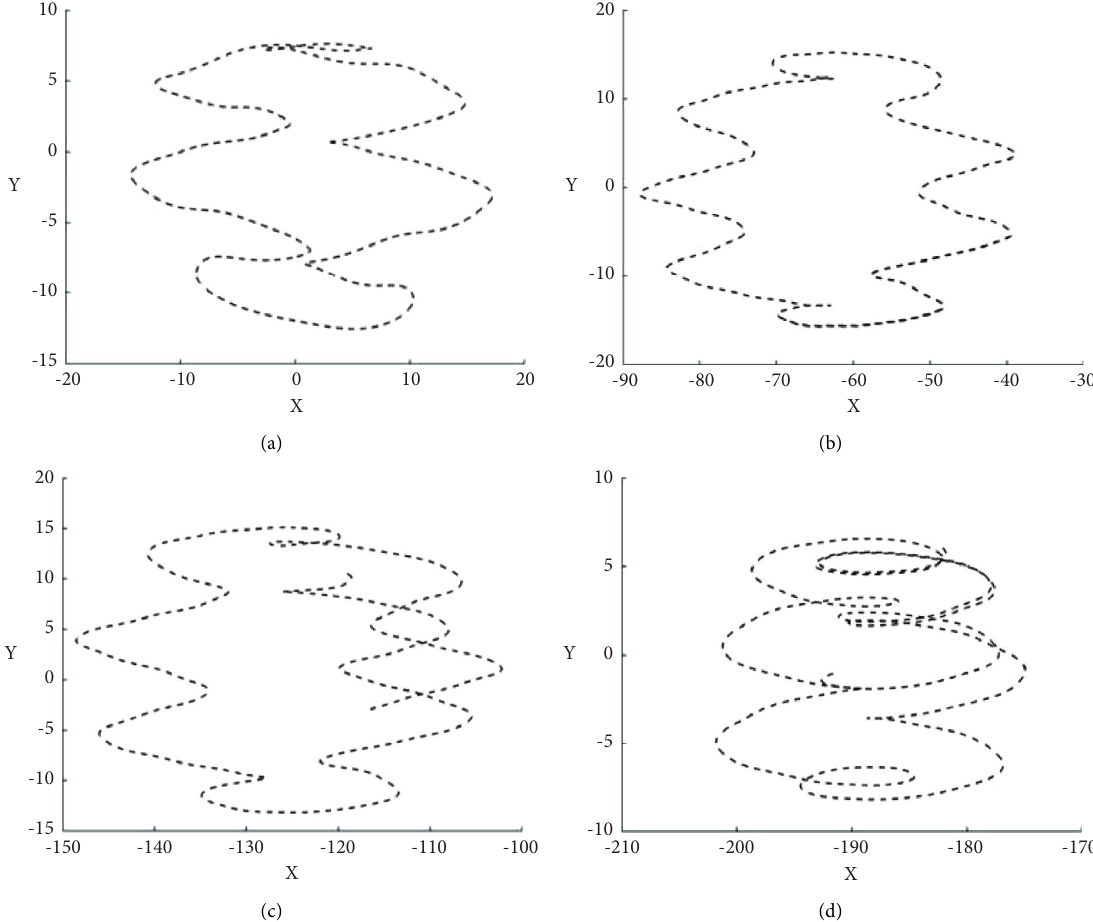
Figure 11: Phase portrait in the plane ( x,y ) for System (2) illustrating megastability obtained by considering random initial conditions distributed around the x -axis. The frequency of the forcing term is ω � 0 . 6, and the amplitude A � 4 . 3. Adding a forcing term can make the system exhibit various